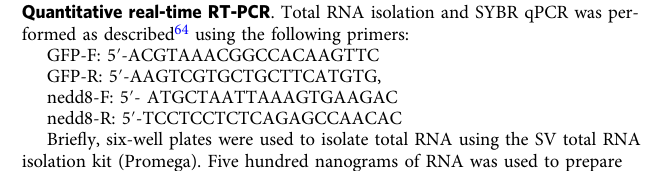
Fig. 7 The HECT E3-ligase HUWE1 is required for stress-induced NEDDylation. a Table showing the SILAC ratio for HUWE1 in the two replicate experiments performed for the aggregate composition upon HS. Heavy, HS; Light, untreated. b H1299 cells were either untreated (DMSO) or exposed to HS (2 h) or to overnight MG132 (5 μ M) treatment. Cells were fi xed and stained for HUWE1. c U2OS cells were transfected with siRNAs and treated as above. Cell extracts were used for western blotting. d U2OS cells were transfected with siRNAs before plasmid transfection of HA-RPL7 and His 6 -NEDD8 as indicated. Cells were exposed to HS (2 h) before Ni-NTA pull-down and western blotting. e , f H1299 cells were siRNA transfected as indicated and either heat-shocked ( e ) or MG132 ( f ) treated as before. Staining and quantitation of nuclear aggregates stained with NEDD8 or ubiquitin was performed as before. Scale bars, 10 µ m. Values represent the average of three independent experiments